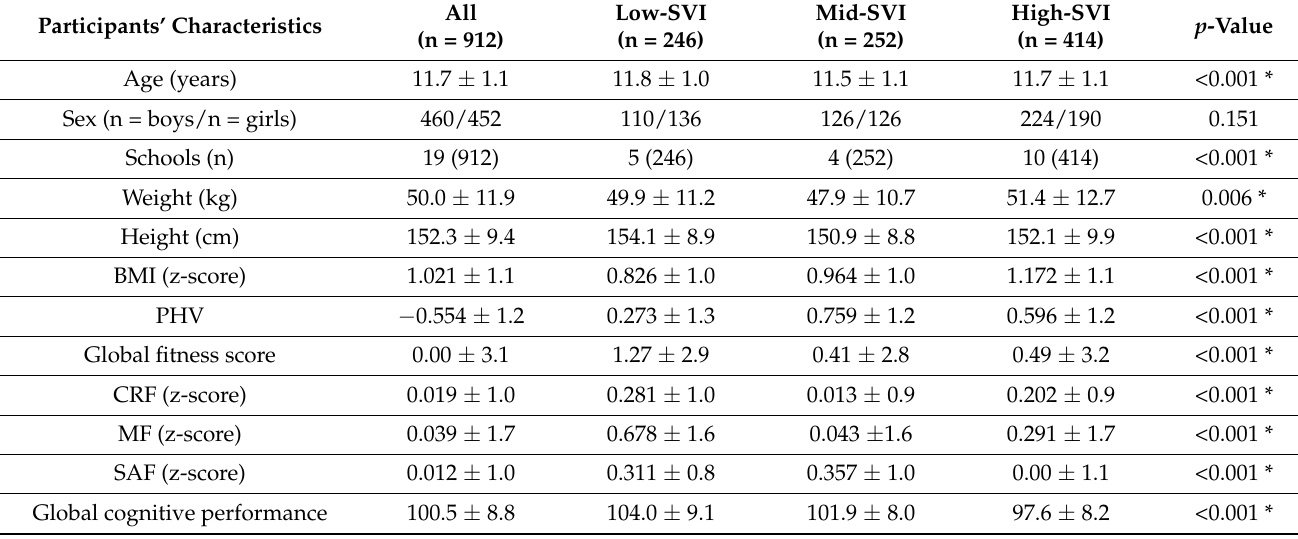
Table 1. Participants’ characteristics (mean ± SD) according to their school vulnerability